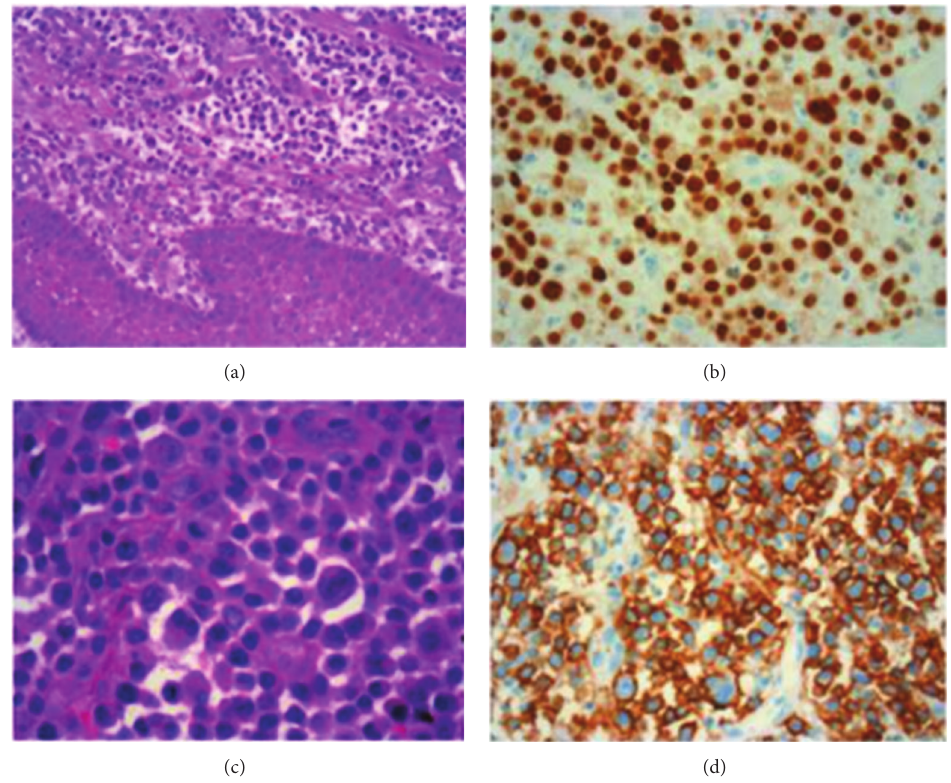
Figure 2: Extramedullary plasmacytoma, microscopic features. (a) The submucosa was heavily infiltrated by atypical plasma cells (hematoxylin eosine stain × 20, Case A). (b) MUM-1 + atypical plasma cells (nuclear staining pattern) ( × 40). (c) Some of the neoplastic plasma cells (pleomorphic or showing atypical mitosis stain × 63, Case B). (d) CD138 + atypical plasma cells (membranous staining pattern, × 40, Case